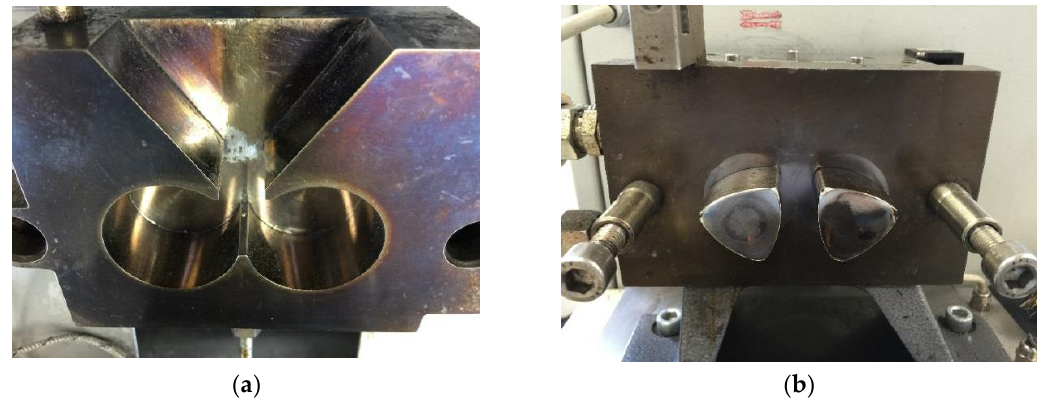
Figure 2. Pictures of measuring mixer ( a ) mixer bowl with an opening on the top to fill testing material ( b ) mixing blades on the rear site.